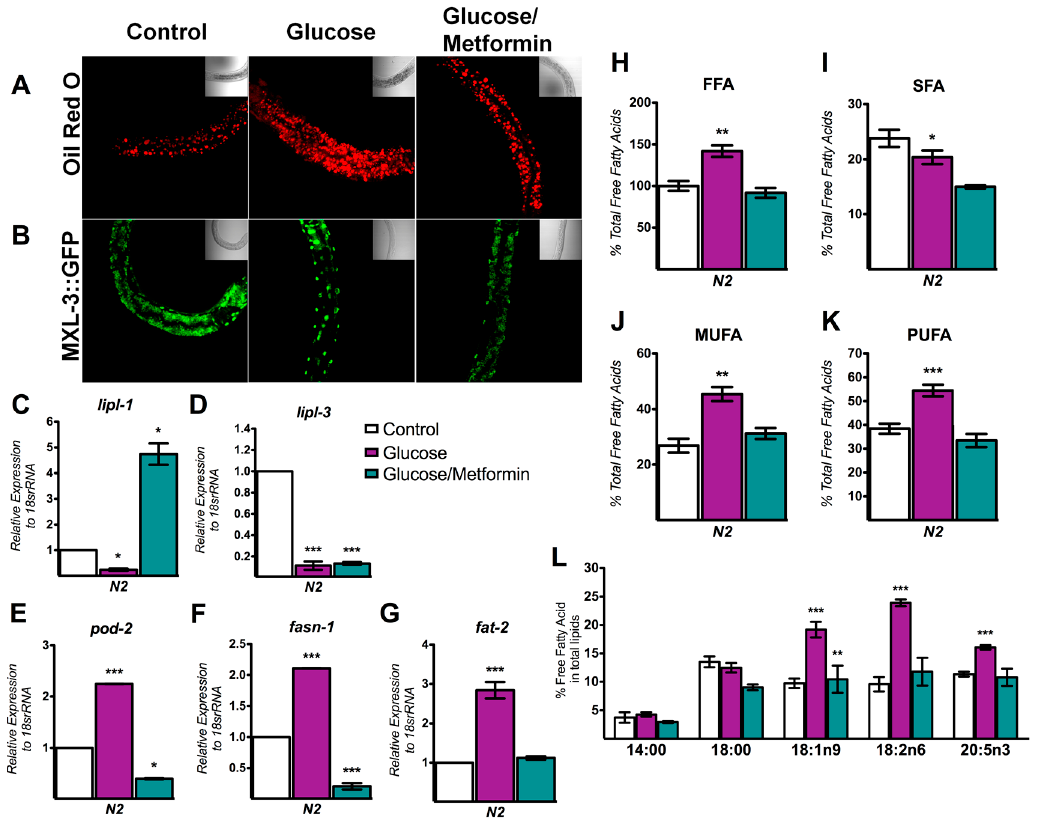
Figure 5. Metformin protects C. elegans against glucose-induced fat accumulation by MXL-3. Metformin decreased lipid storage and modified FFA profiles through MXL-3. ( A , B ) Representative images of lipid droplets indicated by ORO staining (red dots) or the subcellular localization of MXL-3::GFP (green dots) under control, glucose and glucose/metformin conditions. ( C – G ) mRNA gene expression analysis was performed by performing qRT-PCR on wild-type N2 under the same experimental conditions: ( C ) lipl-1 ; ( D ) lipl-3 ; ( E ) fasn-1 ; ( F ) pod-2 ; and ( G ) fat-2 . The relative expression of each gene was normalized to endogenous 18S rRNA gene expression. ( H – L ) Total FFAs and their subgroups are modified similar to the control group when metformin us added: ( H ) FFA; ( I ) SFA; ( J ) MUFA; ( K ) PUFA; and ( L ) fatty acid profile. Data represent the mean ± SEM of three independent experiments; * p < 0.05, ** p < 0.01, *** p < 0.001, one-way ANOVA with Bonferroni’s post hoc test using GraphPad Prism.